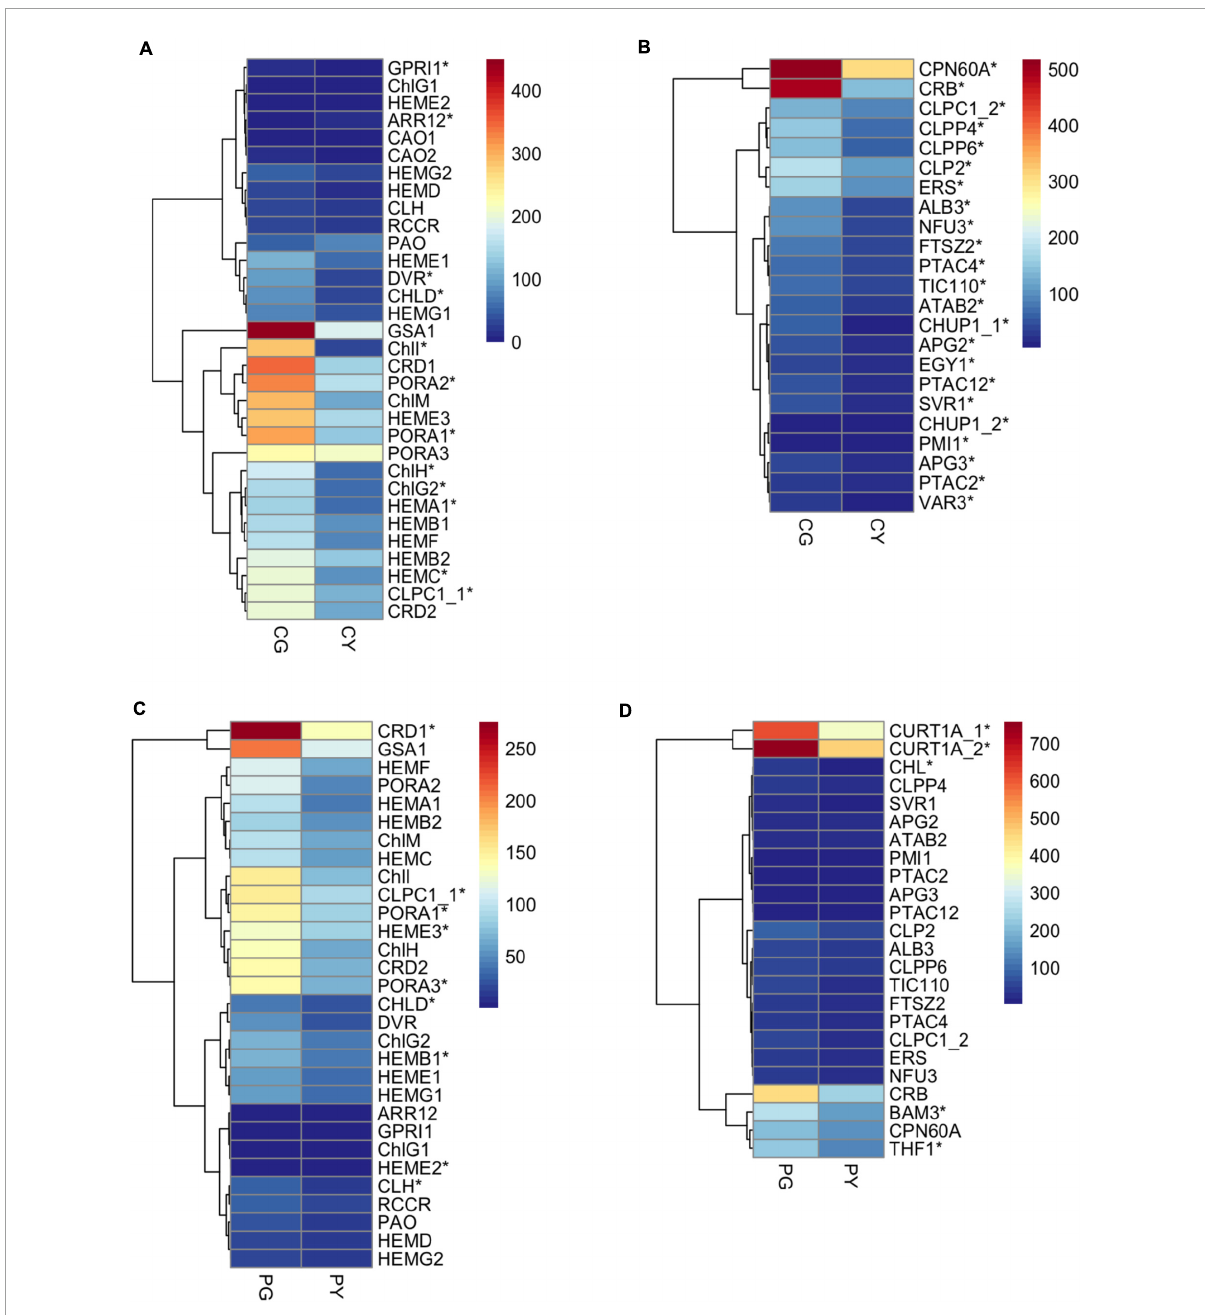
FIGURE6 The expression pattern of key genes related to chlorophyll biosynthesis and chloroplast development in the transiently silenced Forsythia plants. (A) DEGs related to chlorophyll biosynthesis in the comparison of CG vs. CY; (B) DEGs related to chloroplast development in the comparison of CG vs. CY; (C) DEGs related to chlorophyll biosynthesis in the comparison of PG vs. PY; (D) DEGs related to chloroplast development in the comparison of PG vs. PY.